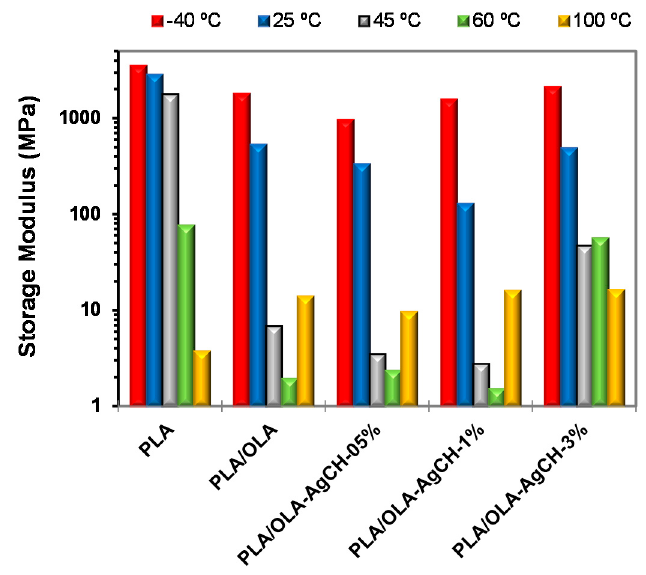
Figure 5. Storage Modulus, E´, at different temperatures.